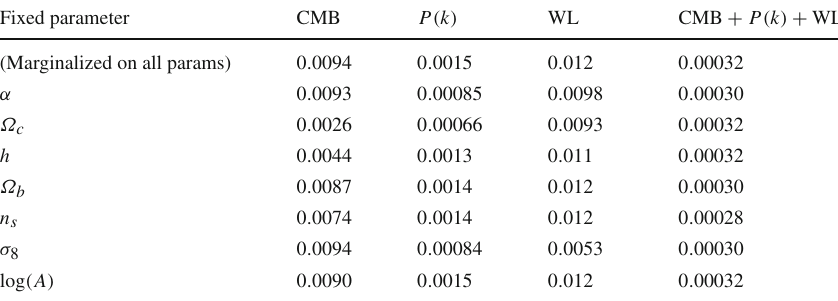
Table 14 1- σ errors for β 2 , for CMB, P ( k ) , WL and CMB + P ( k ) +